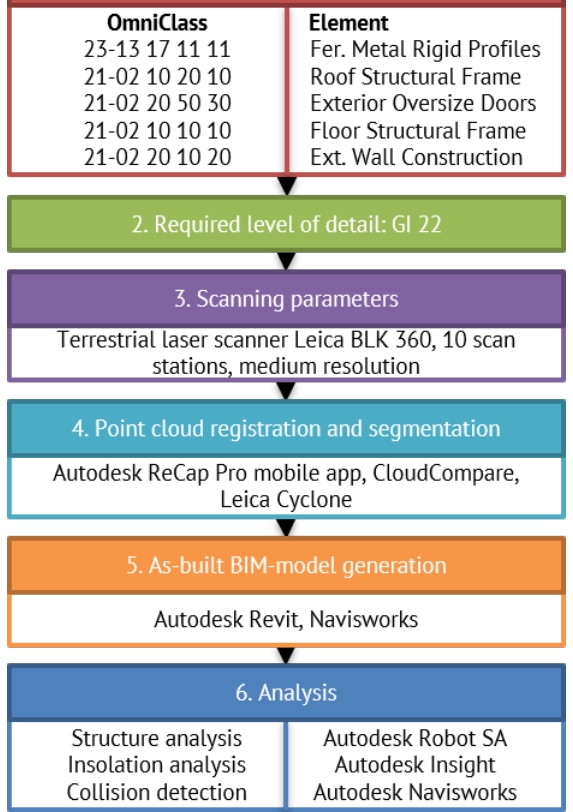
Figure 7. Scheme of the proposed methodology, which is tuned for the case study for existing industrial sites